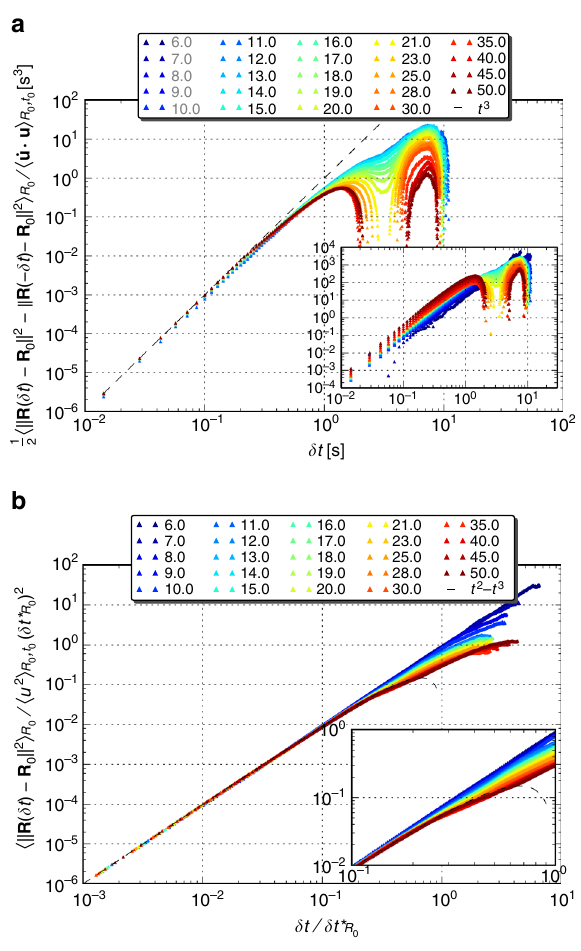
Fig. 5 Relative pair dispersion time asymmetric terms and dimensionless form. a Taking the difference between the data sets plotted in the insets of h R ð δ t Þ (cid:3) R k k 2 (cid:3) R ð(cid:3) δ t Þ (cid:3) R k k 2 i Fig. 4, 1 , exposes the contribution of 0 0 R 0 2 the time asymmetric terms, odd powers in δ t , presented here in the inset (sign inverted). Rescaling by the empirical estimator for _ u (cid:4) u h i , these R 0 ; t 0 data collapse on δ t 3 initially; the data sets of R 0 ≤ 10 μ m ( grey in the legend ) are omitted from the main fi gure due to the scatter of the estimator; Supplementary Fig. 3. The plot shows a deviation from δ t 3 at times shorter than 300 ms, indicating the dominance of higher order (odd) terms at early times and that the δ t 3 term alone does not trivially explain the deviation from δ t 2 , observed in Fig. 4 after more than 2 s. b Rescaling the relative pair ð δ t (cid:5) Þ 2 (see Eq. (2)), results in dispersion data (inset of Fig. 4a) by h u 2 i R 0 ; t 0 R 0 a dimensionless form, plotted here against dimensionless time, δ t rescaled ¼ jh u 2 i = _ u (cid:4) u h i j ; the empirical estimators of δ t (cid:5) by δ t (cid:5) can be R 0 ; t 0 R 0 ; t 0 R 0 R 0 found in Supplementary Fig. 4. The data sets indeed collapse onto a single ; approaches unity zoom-in ( inset ) emphasises the behaviour as δ t = δ t (cid:5) R 0